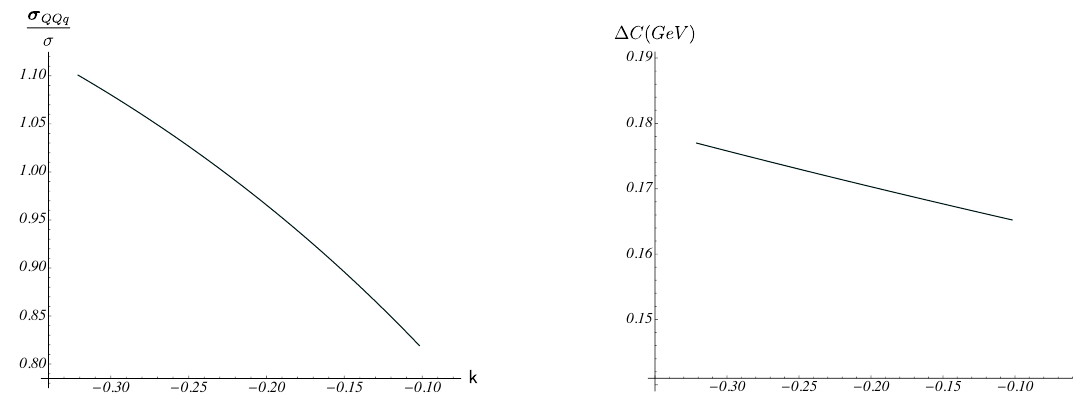
Figure 5 . Left: tension σ in units of σ versus k . Right: ∆ C versus k for the parameter set L . QQq In both cases, k runs from − 0 . 321 to − 0 . 102 .